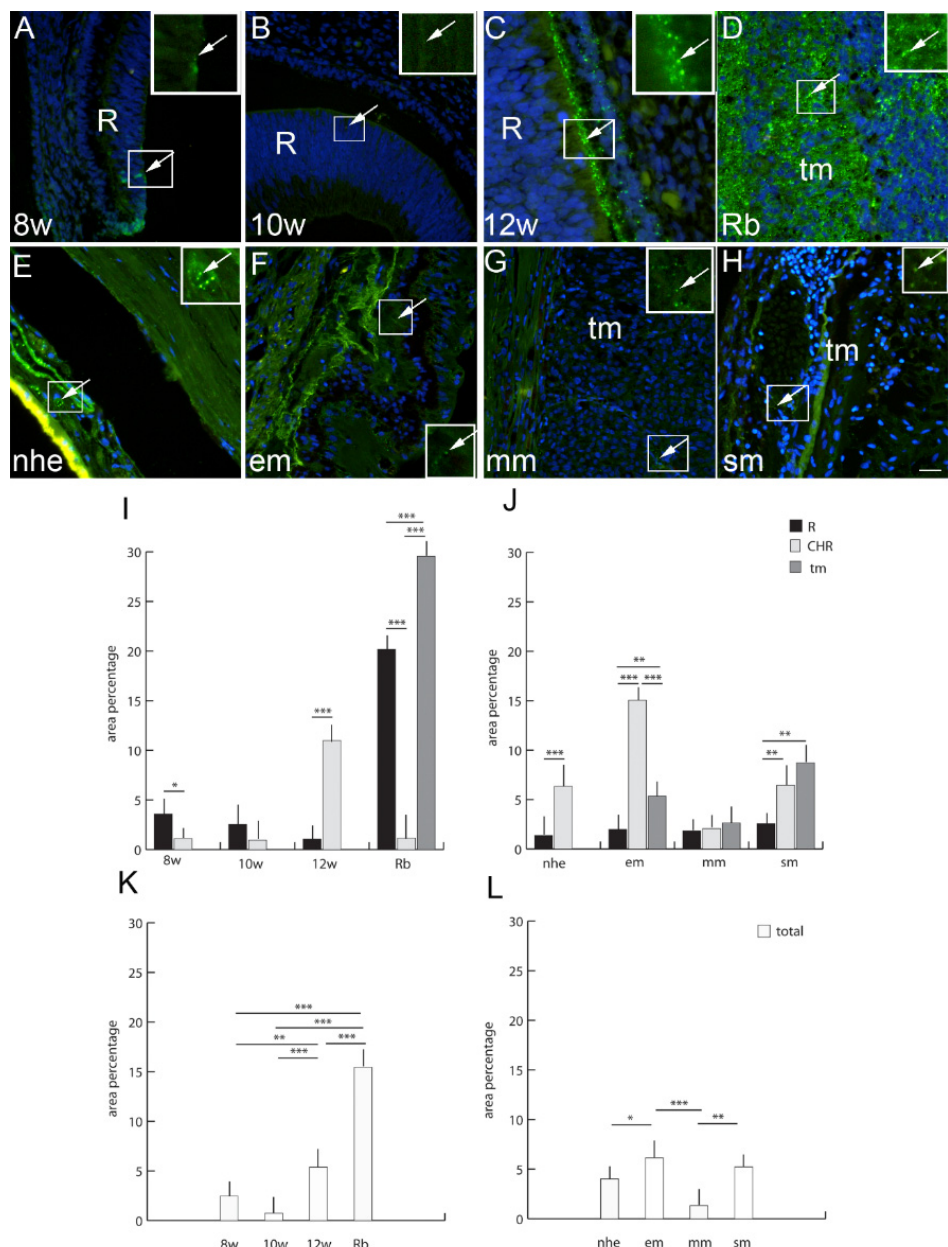
Figure 6. Panexin 1 (Pnx1)-positive cells (arrows) can be seen in the eye section of an 8th-week (8 w) ( A ), 10th-week (10 w) ( B ) and 12th-week (12 w) ( C ) human embryo, retinoblastoma (Rb) ( D ), normal human eye (nhe) ( E ), epitheloid melanoma (em) ( F ), mixoid melanoma (mm) ( G ) and spindle melanoma (sm) ( H ); R—retina, tm—tumor tissue. Immunofluorescence staining to Pnx1 (green) merged to DAPI (blue nuclei), scale bar 25 μ m. The panel with graphs represents the area percentages of Pnx1 in the retina (R), choroid (CHR) and tumor (tm) in the 8th-week (8 w), 10th-week (10 w) and 12th week (12 w) human embryo, retinoblastoma (Rb), normal human eye (nhe), epitheloid melanoma (em), mixoid melanoma (mm) and spindle melanoma (sm) ( I , J ), and total area percentage of Pnx1 ( K , L ). Data are shown as mean ± SD. Significant differences are indicated by * p < 0.05, ** p < 0.01, and *** p < 0.001. One-way ANOVA followed by Tukey’s multiple-comparisons test (comparison between Rb and uveal melanoma types), t -test (comparison between retina and choroid of developmental stages and normal human eye).